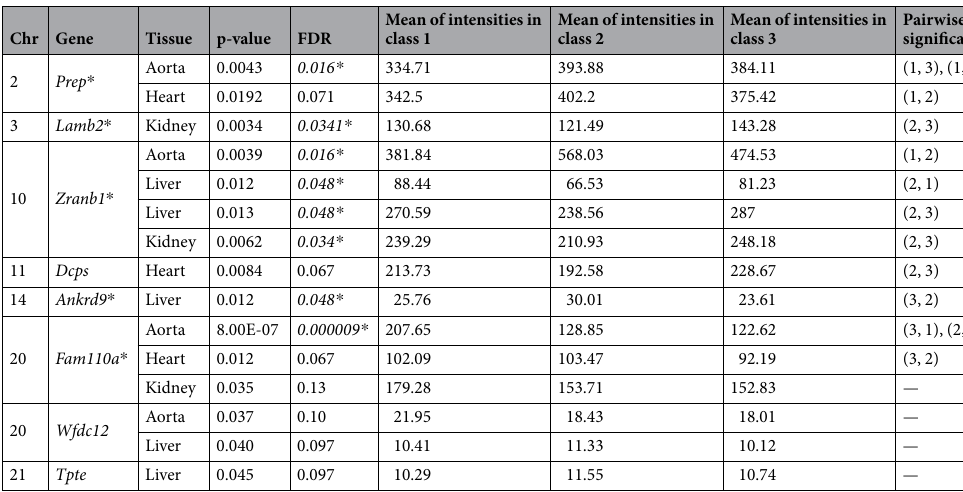
Table 4. Results of validation study in the hypertensive mouse model. FDR: False discovery rate; * FDR < 0.05. Only the genes which p-value < 0.05 were shown in this table. Class 1: Hypotensive mouse model, class 2: Normotensive mouse, class 3: Hypertensive